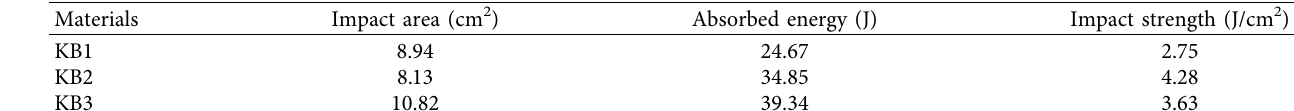
Table 5: Impact strength of the samples.